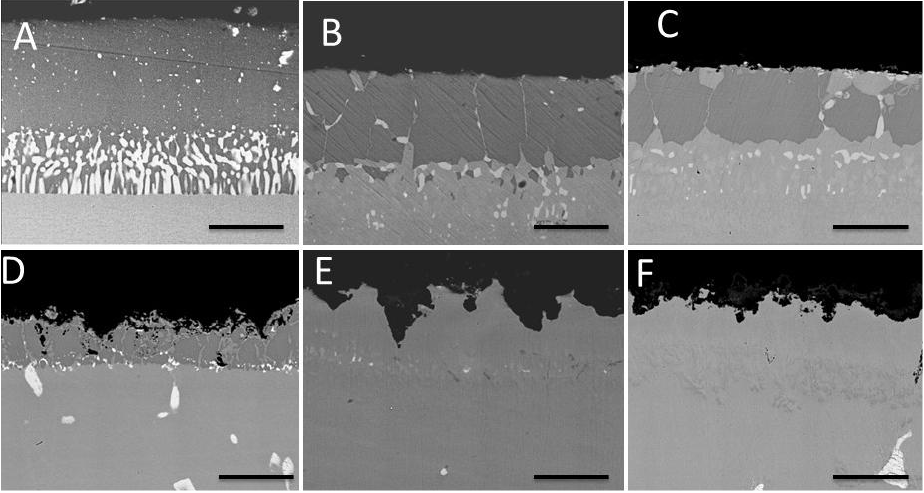
Figure 2. SEM images (BSE signal) of the aluminized IN738 as function of the isothermal test duration ( A , D = 0 h; B , E = 500 h; C , F = 1000 h) for IN738 + pack aluminizing + heat treatment ( A – C ) and IN738 + IL Aluminizing + heat treatment ( D – F ). Scale bar 25 μ m.